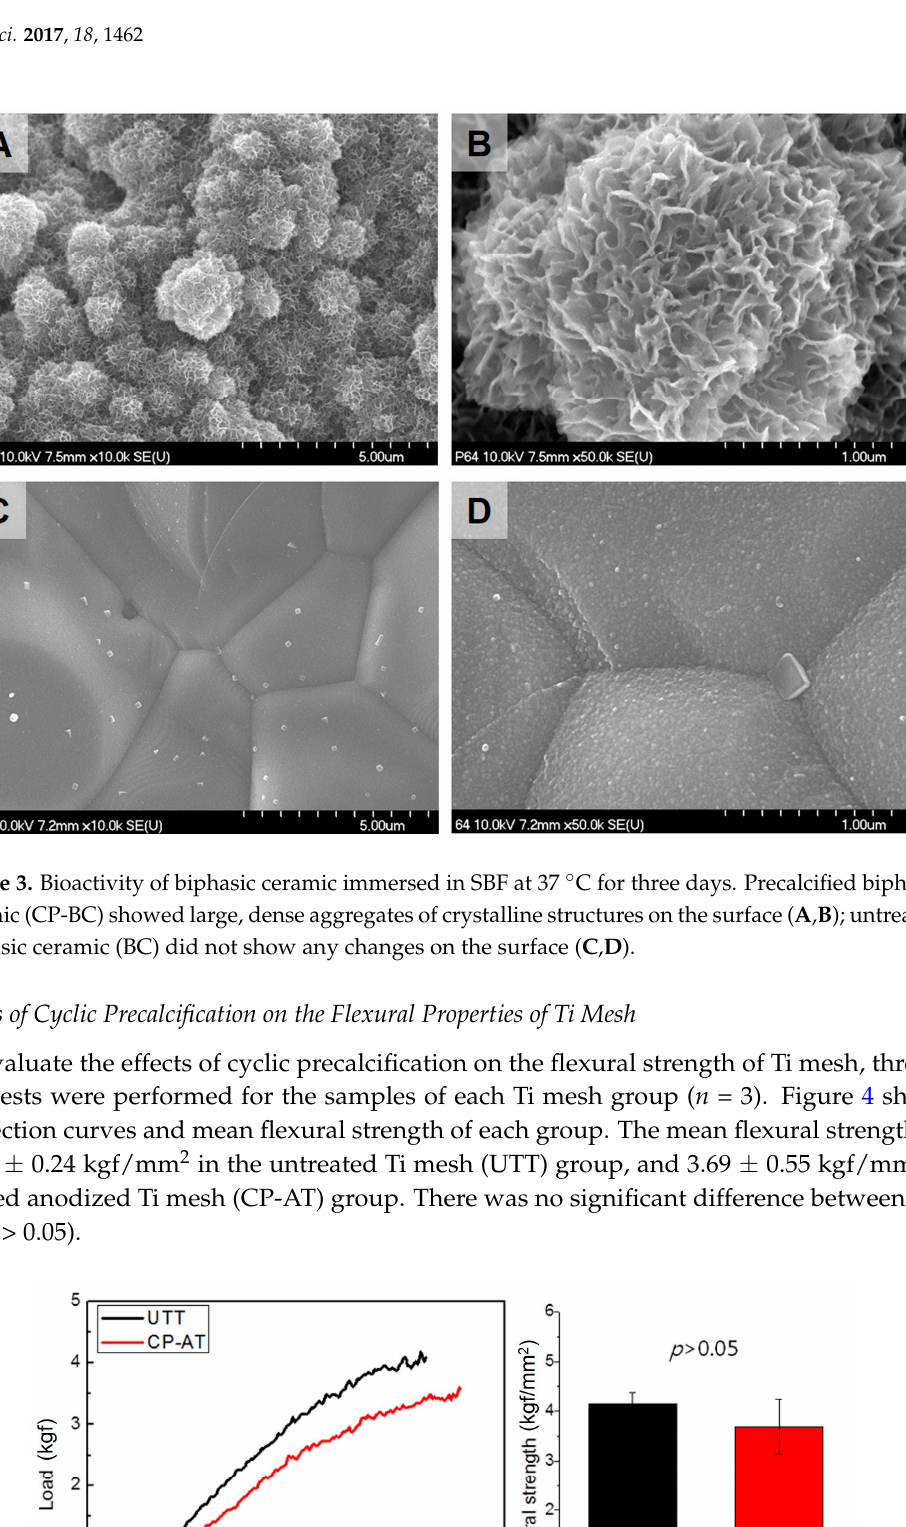
Figure 4. Three-point flexural testing of untreated Ti mesh (UTT) and cyclic precalcified Ti mesh (CP-AT).